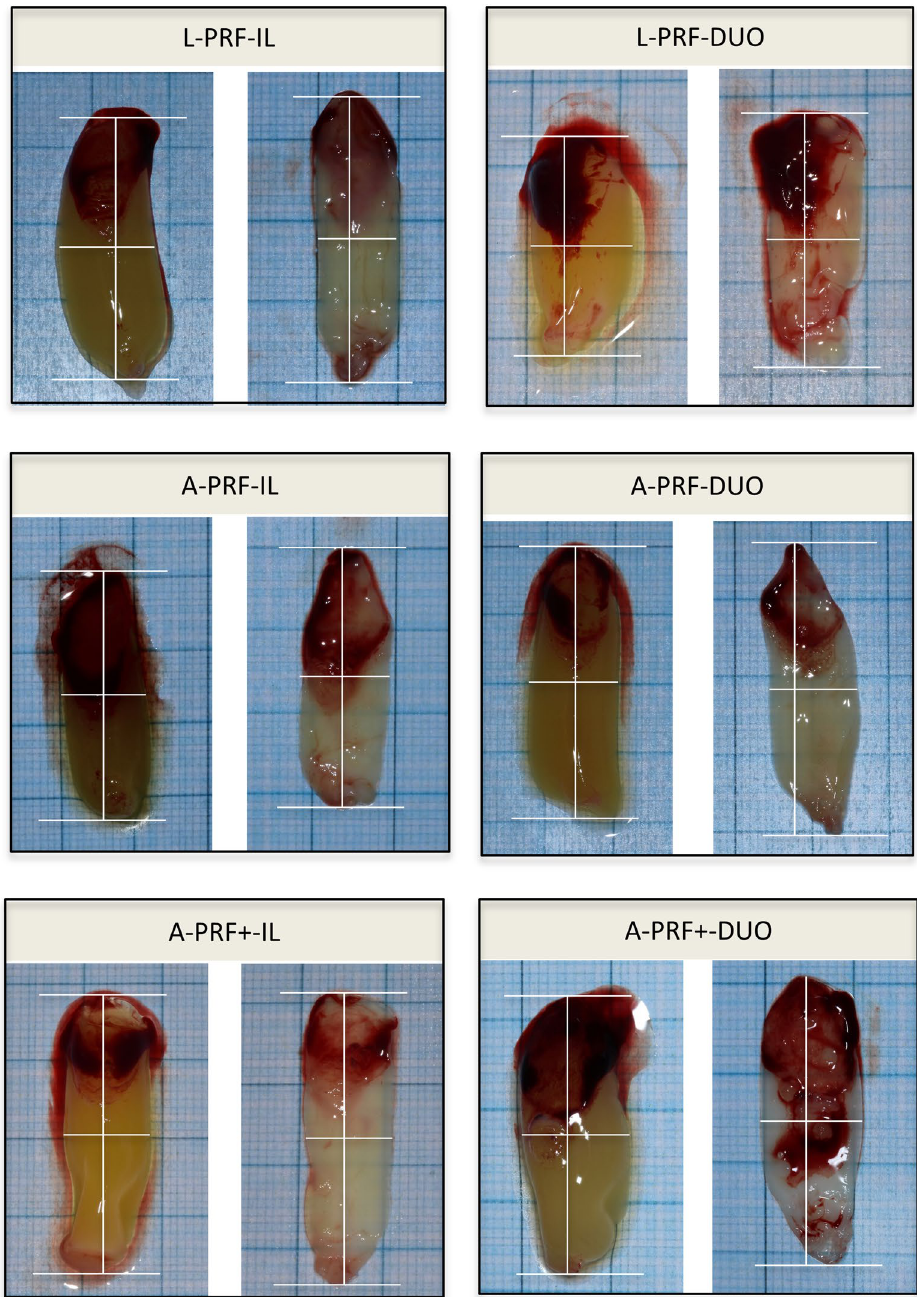
Figure 3. Standardized pictures and measurements of the clots and membranes. The length and the width of each clot and membrane were measured with a horizontal (length) and a vertical (width) line drawn from the middle point of the clot or membrane with an angle of